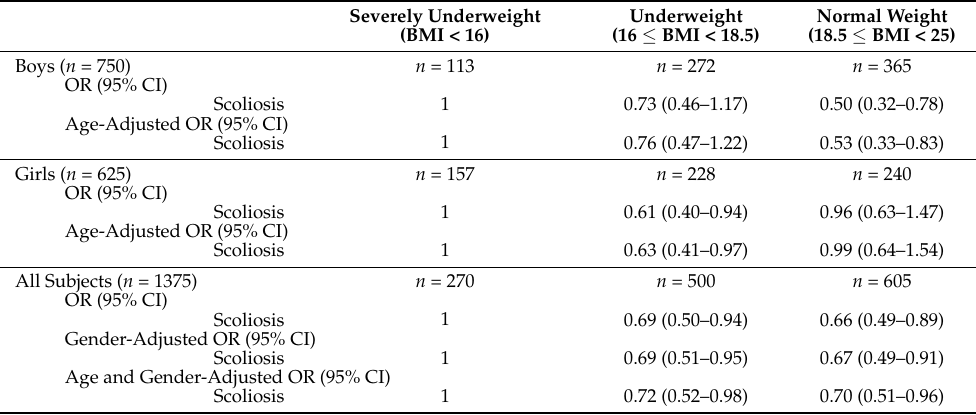
Table 3. Odds ratios according to BMI